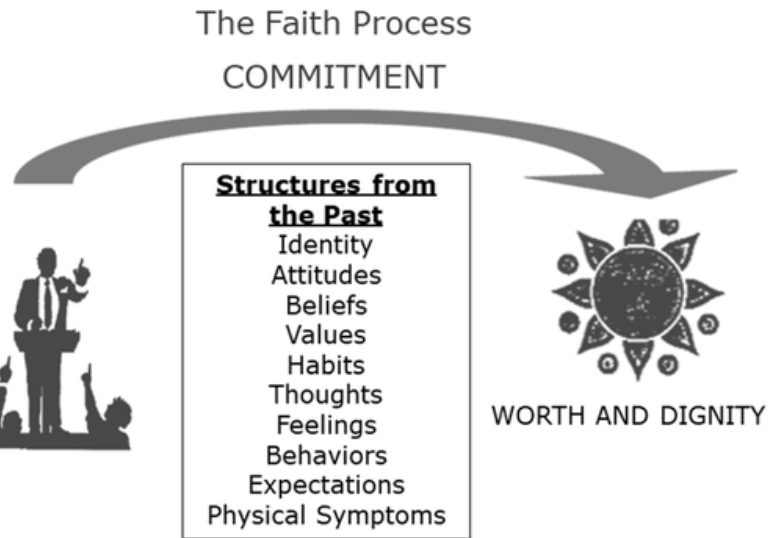
Figure 6. Making a commitment to the worth and dignity of every person creates increased aware- ness of blocks (aspects of past personal experiences) that prevent individuals from keeping this commitment. Processing these blocks increases a person’s self-worth and dignity as it opens the spiritual core.